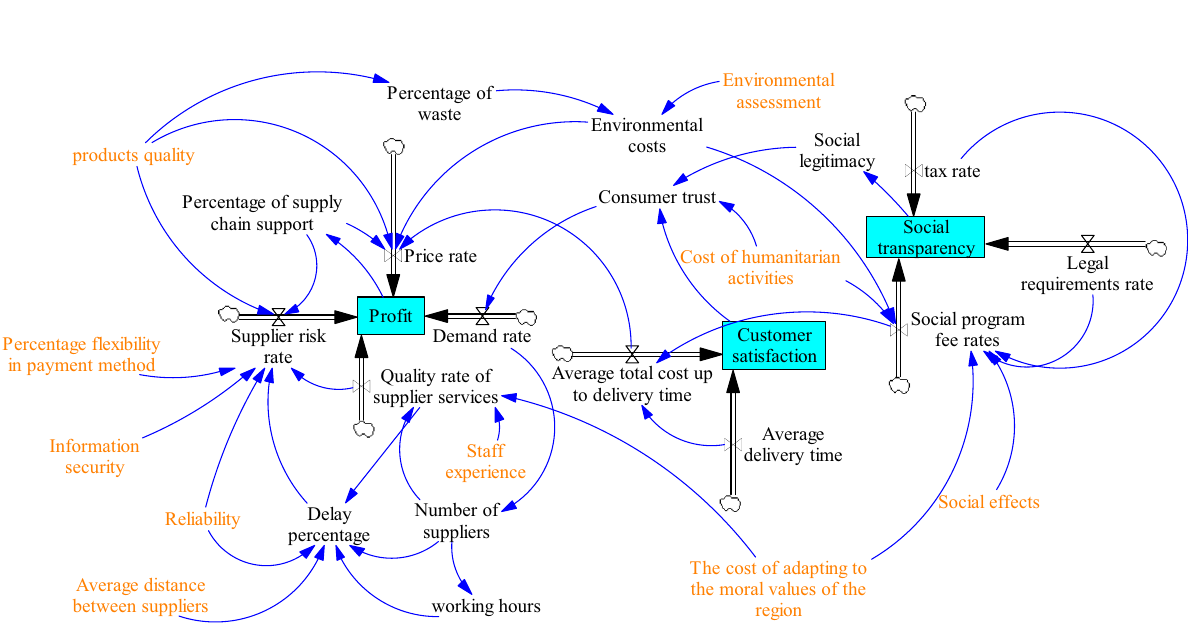
(b) The stock-flow model